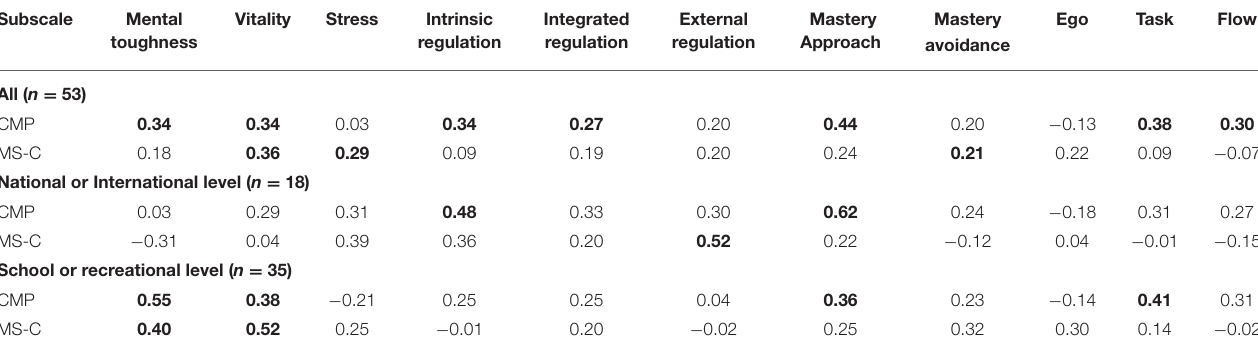
TABLE 4 | Pearson’s correlations between the MSRS and relevant psychological scores for a part of the Singapore sample ( n = 53). Subscale